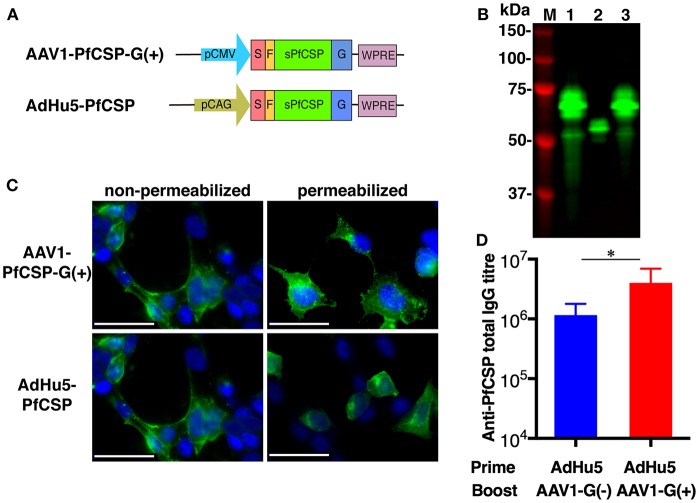
Functional activity of AAV1-PfCSP-G(+). (A) Constructs of AAV1-PfCSP-G(+) and AdHu5-PfCSP-G(+). Expression of the pcsp gene cassette in AAV1 and AdHu5 was driven by a CMV promoter and CAG promoter, respectively. G, VSV-G. (B) Expression of PfCSP in HEK293T cells transduced with AdHu5-PfCSP (lane 1, MOI = 3), AAV1-PfCSP-G(–) (lane 2, MOI = 105), or AAV1-PfCSP-G(+) (lane 3, MOI = 105), as assessed by immunoblotting with mAb 2A10 at 48 h post-transduction. (C) Localization of PfCSP expression in HEK293T cells transduced with AAV1-PfCSP-G(+) (MOI = 105) and AdHu5-PfCSP (MOI = 10), as determined by IFA conducted as described in Figure 2C. (D) Anti-PfCSP IgG antibody responses. Groups of BALB/c mice (n = 10) were immunized with the indicated regimen at a 6-week interval. At 4 weeks post-boost, serum samples were collected from each mouse, and their anti-PfCSP IgG titers were determined by ELISA. AdHu5-PfCSP, AAV1-PfCSP-G(–), and AAV1-PfCSP (G+) are shown as AdHu5, AAV1-G(–), and AAV1-G(+), respectively. Bars and error bars indicate the means and SD of the values, respectively. Between-group differences were assessed with a Mann–Whitney U-test (*p < 0.05).